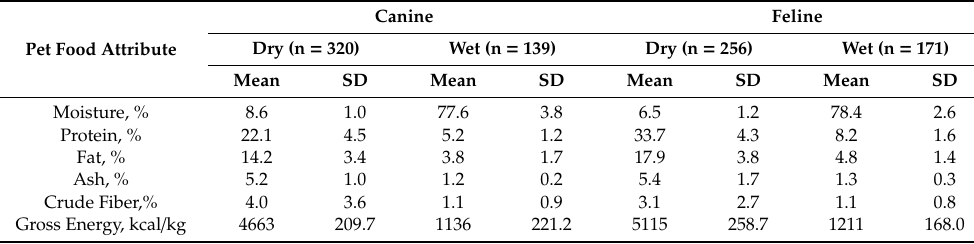
Table 2. Pet food chemical composition (means and standard